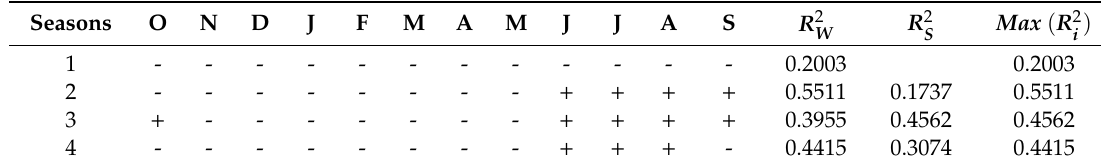
Figure 4. Monthly empirical average values computed for α . Table 3. Definition of the seasons.